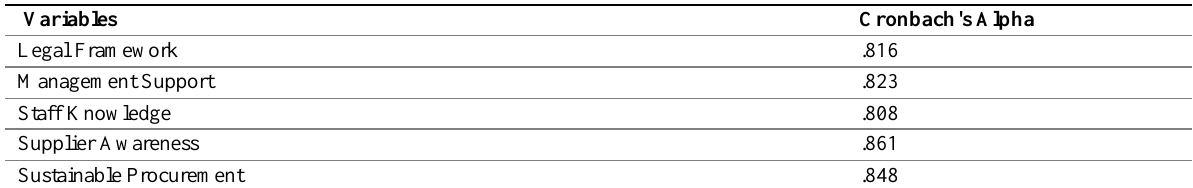
Table 1: Reliability Test